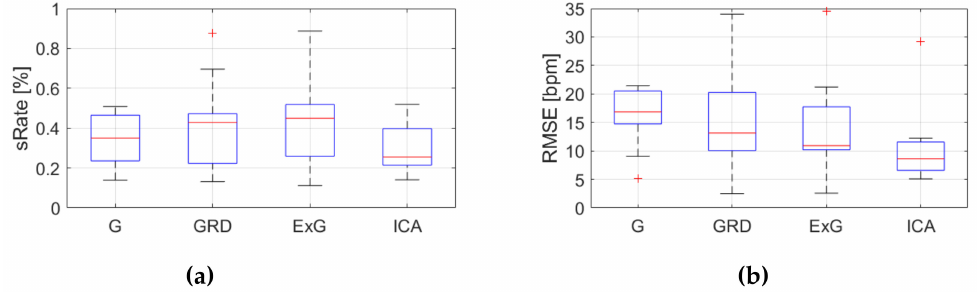
Figure 8. Comparison of signal extraction methods, algorithm No.3 (TIME): ( a ) box plots for sRate ; ( b ) box plots for RMSE . Blue lines—IQR range, red line—median